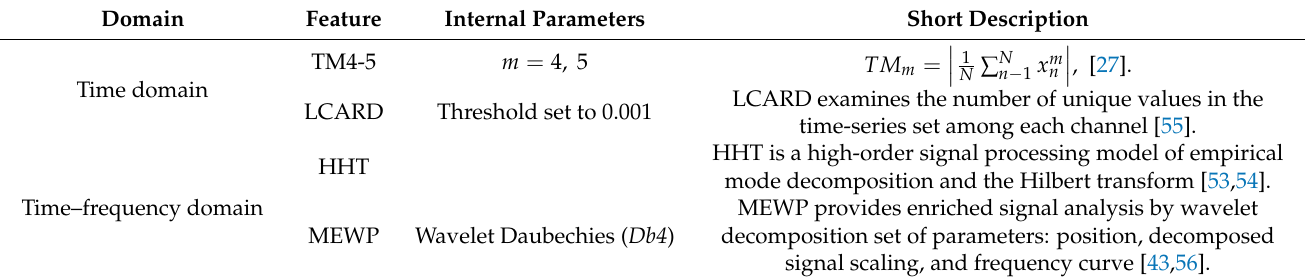
Table 1. ASF-4 multidomain feature set